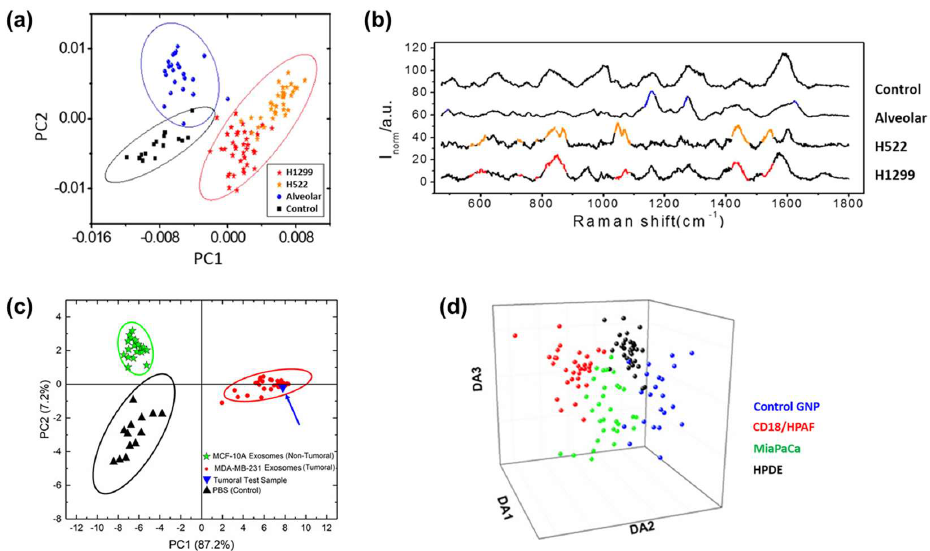
Figure 9. Principal component analysis (PCA) and combination with the discrimination method for EVs-SERS signal analysis. ( a ) PCA score plot of normal alveolar cell- and lung cancer cells-derived EVs. ( b ) The dominant spectral pattern of each EVs group was determined by means of PCA loading data. Adapted with permission from Ref. [59]. Copyright 2017 American Chemical Society. ( c ) Prediction of a tumoral test sample by projection to the pre-classified PCA plot. The projected spectrum of the tumoral test sample was located within the 95% confidence ellipse of tumoral EVs. Adapted with permission from Ferreira, N.; Marques, A. et al., Label-free nanosensing platform for breast cancer EVs profiling. ACS sensors 2019, 4, (8), 2073-2083. Copyright 2020 American Chemical Society. ( d ) Classification of pancreatic epithelial cell (HPDE)- and pancreatic cancer cells (MiaPaCa and CD18/HPAF)-derived EVs using PC-DFA. Adapted from Ref. [54]., Copyright 2019, with permission from Elsevier.